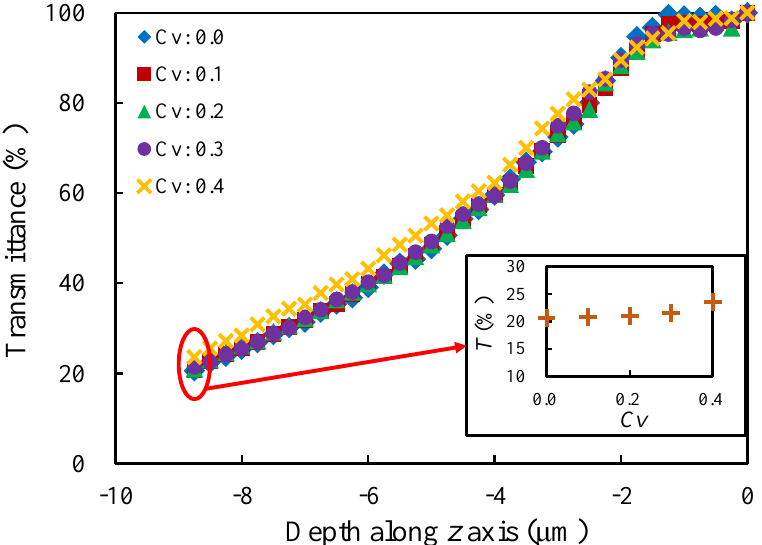
Figure 12. Evolution of the transmittance with the depth along z axis for the models with different coefficients of